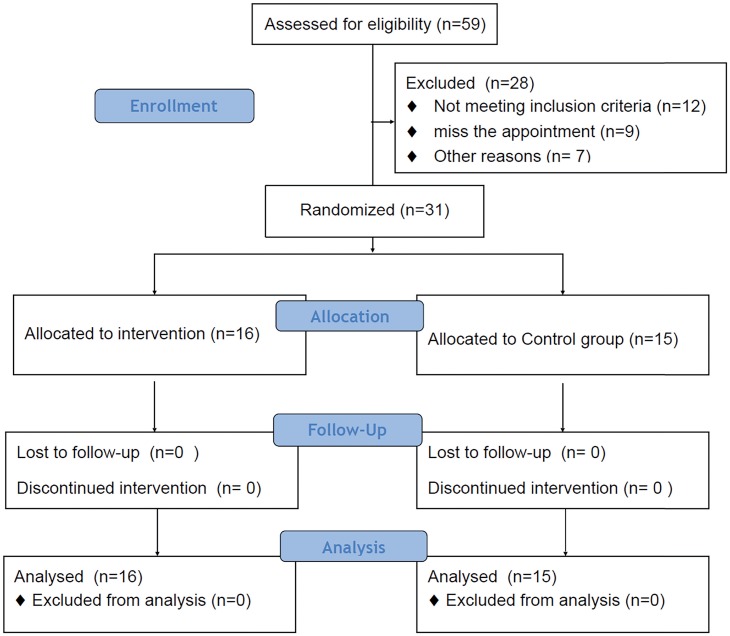
Consort flowchart.